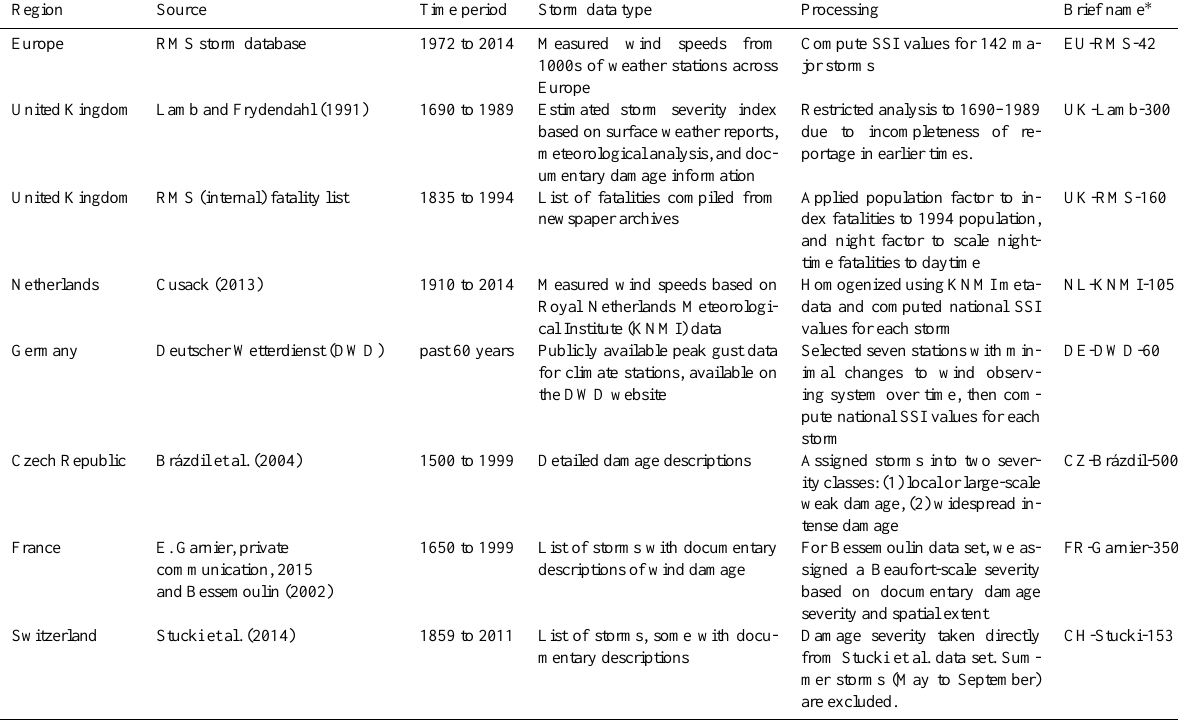
Table 1. Summary of storm data